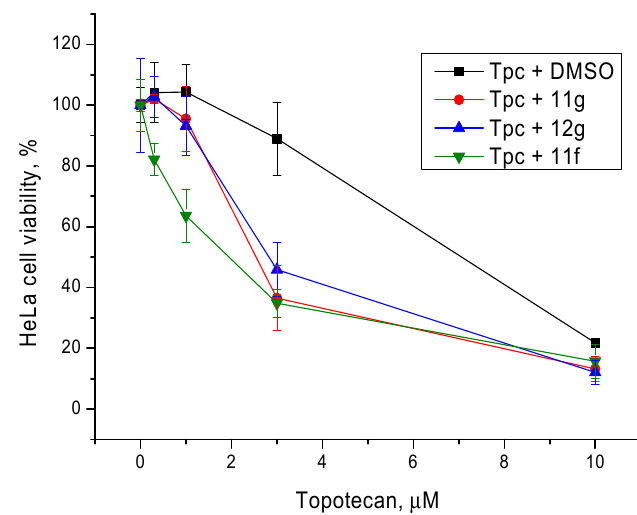
Figure 6. The influence of the Tdp1 inhibitors at 5 µM on topotecan cytotoxicity. Error bars show standard deviations. Table 3. The influence of the Tdp1 inhibitors at 5 µM on the cytotoxic potential of topotecan (Tpc).